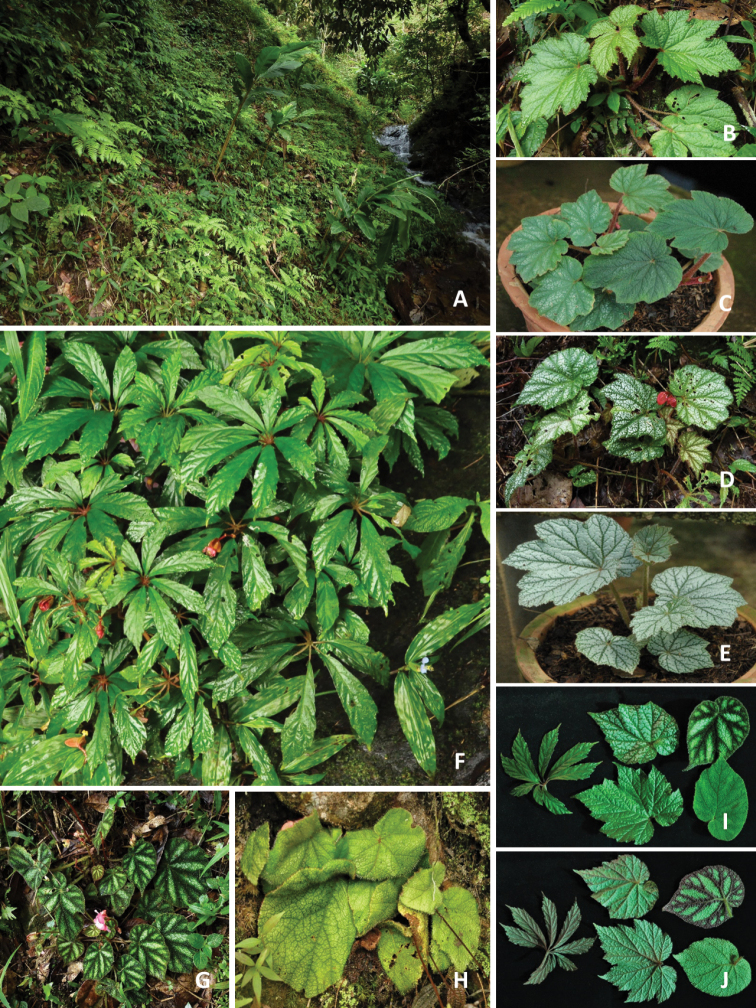
Begonia × malipoensis and its parents (B.
hemsleyana and B.
versicolor) (Photos by Daike Tian) A habitat of a natural hybrid zone of B.
versicolor × B.
hemsleyanaB–E variation of B. × malipoensisFB.
hemsleyanaG, HB.
versicolor with variegated and pure green leaves I, J comparison of B. × malipoensis (middle two leaves) and its parents B.
hemsleyana (left) and B.
versicolor (right two leaves) (I adaxial view J abaxial view).